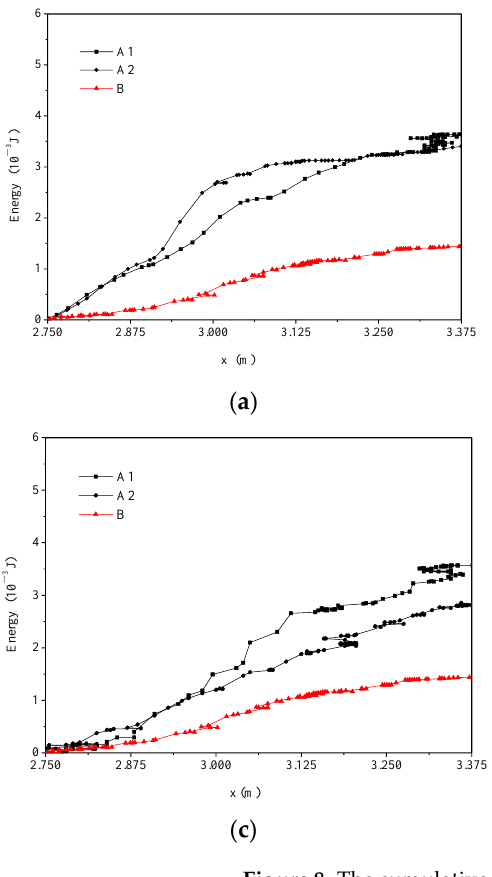
Figure 8. The cumulative energy expenditure of fish under three typical hydraulic conditions: ( a ) high velocity zone, ( b ) high TKE zone, and ( c ) high SR zone (Note: the x axis represents the coordinate value of pool 3 along the x direction, the black lines represent fish movement trajectories when passing through high V, TKE and SR zones, the red line represents fish movement trajectories without passing through the above-mentioned high zones).